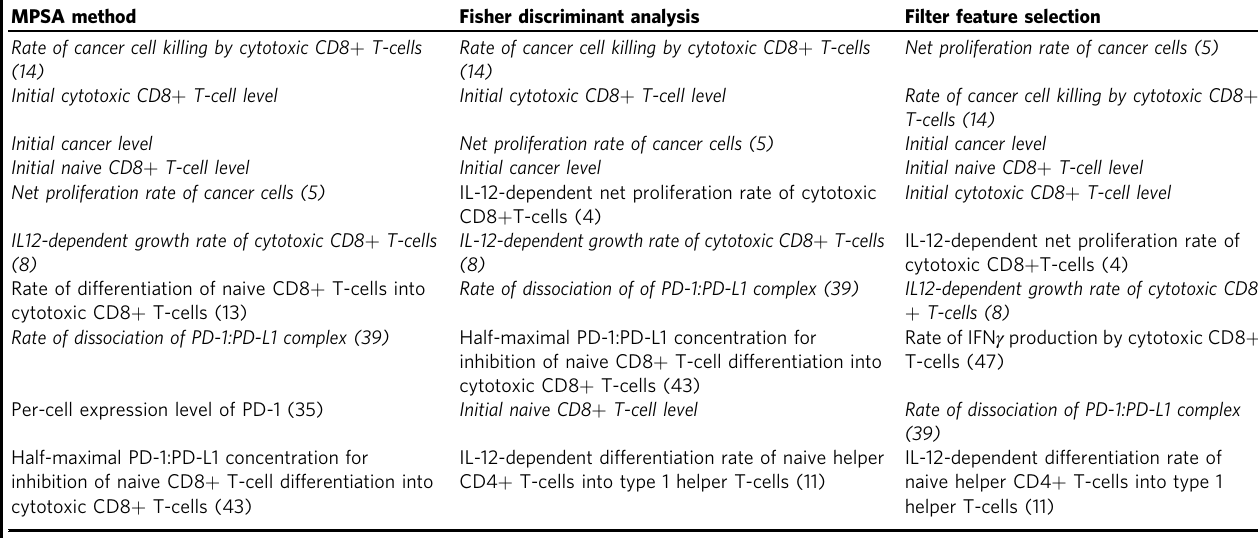
Table 1 Top 10 tumor micro-environment features selected by the MPSA method, Fisher discriminant analysis, and fi lter feature